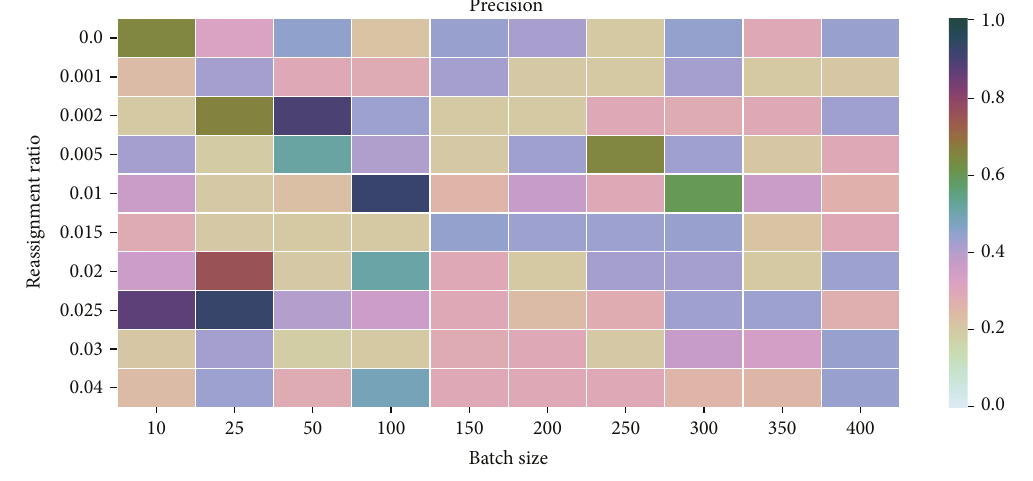
Figure 8: Heatmap of precision scores. Table 3: Clusters of sediment grain-size samples.